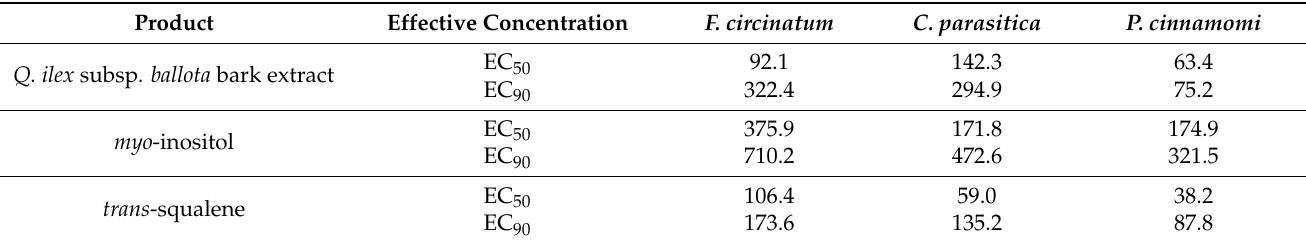
Table 2. EC 50 and EC 90 effective concentrations (in µ g · mL − 1 ) of Q. ilex subsp . ballota bark extract and its main constituents against the pathogens under